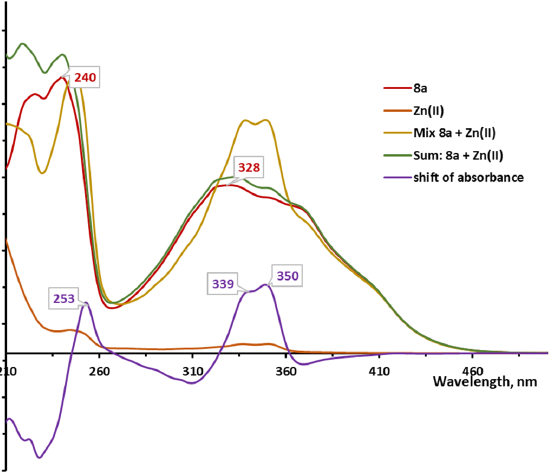
Figure 7. Absorption spectra of compound 8a (40 µ M), Zn 2+ ion solution (40 µ M), a sum of 8a and Zn 2+ , their mixture, and the shift of the spectra caused by the formation of a